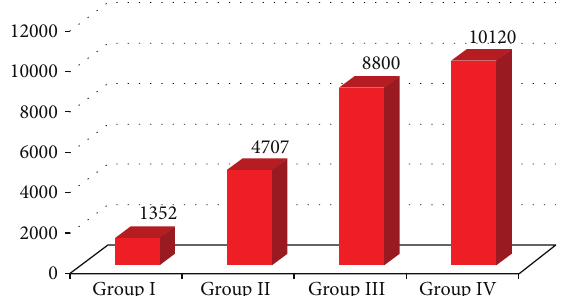
Figure 2: Average cost per patient in the four engagement groups. Costs are expressed in